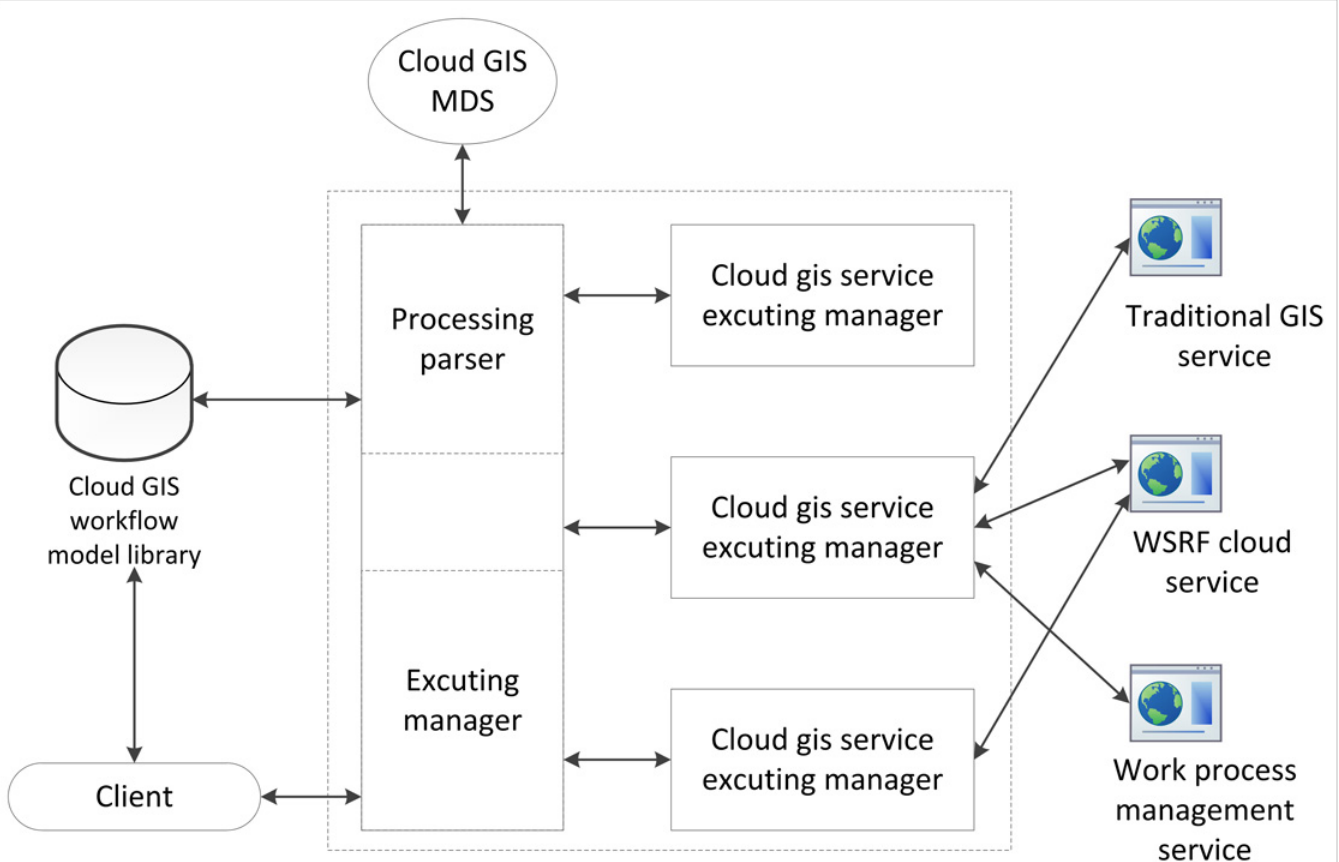
Fig 7. Distributed workflow engine deployment